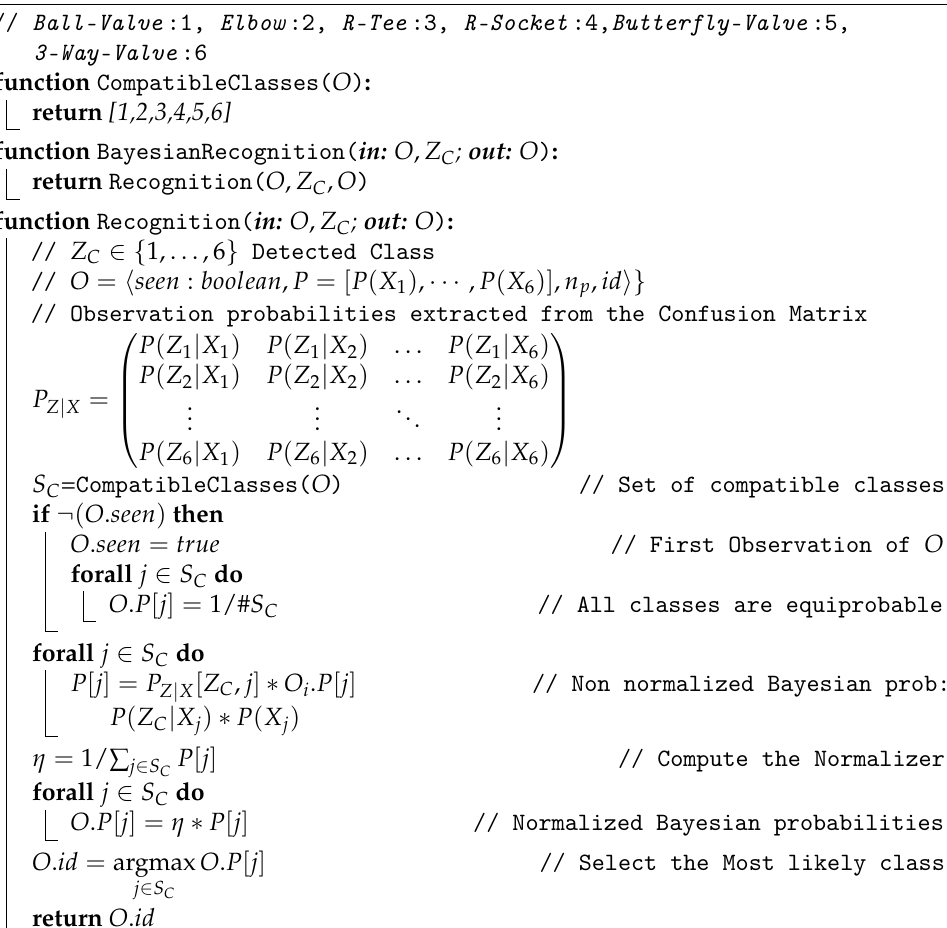
Algorithm 4: Bayesian-based